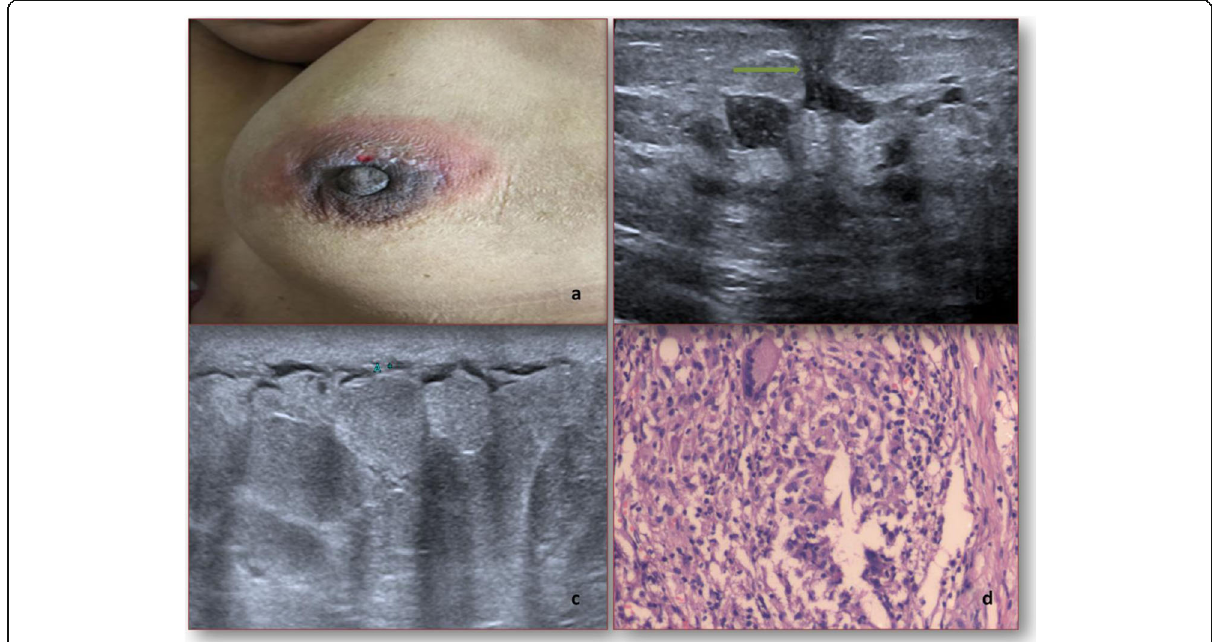
Fig. 3 A 29-year-old female diagnosed with idiopathic granulomatous mastitis, who presented with complaints of pus discharge from sinus tract in the left breast with associated pain. a Clinical picture showing external sinus tract with redness and swelling in the left breast. b A sinus tract (green arrow) between the parenchymal collection and subcutaneous collection to the skin surface. c Ultrasound showing subcutaneous edema and significant skin thickening. d Histopathology showing epithelioid granuloma with Langhans type of giant cells — H&E ×